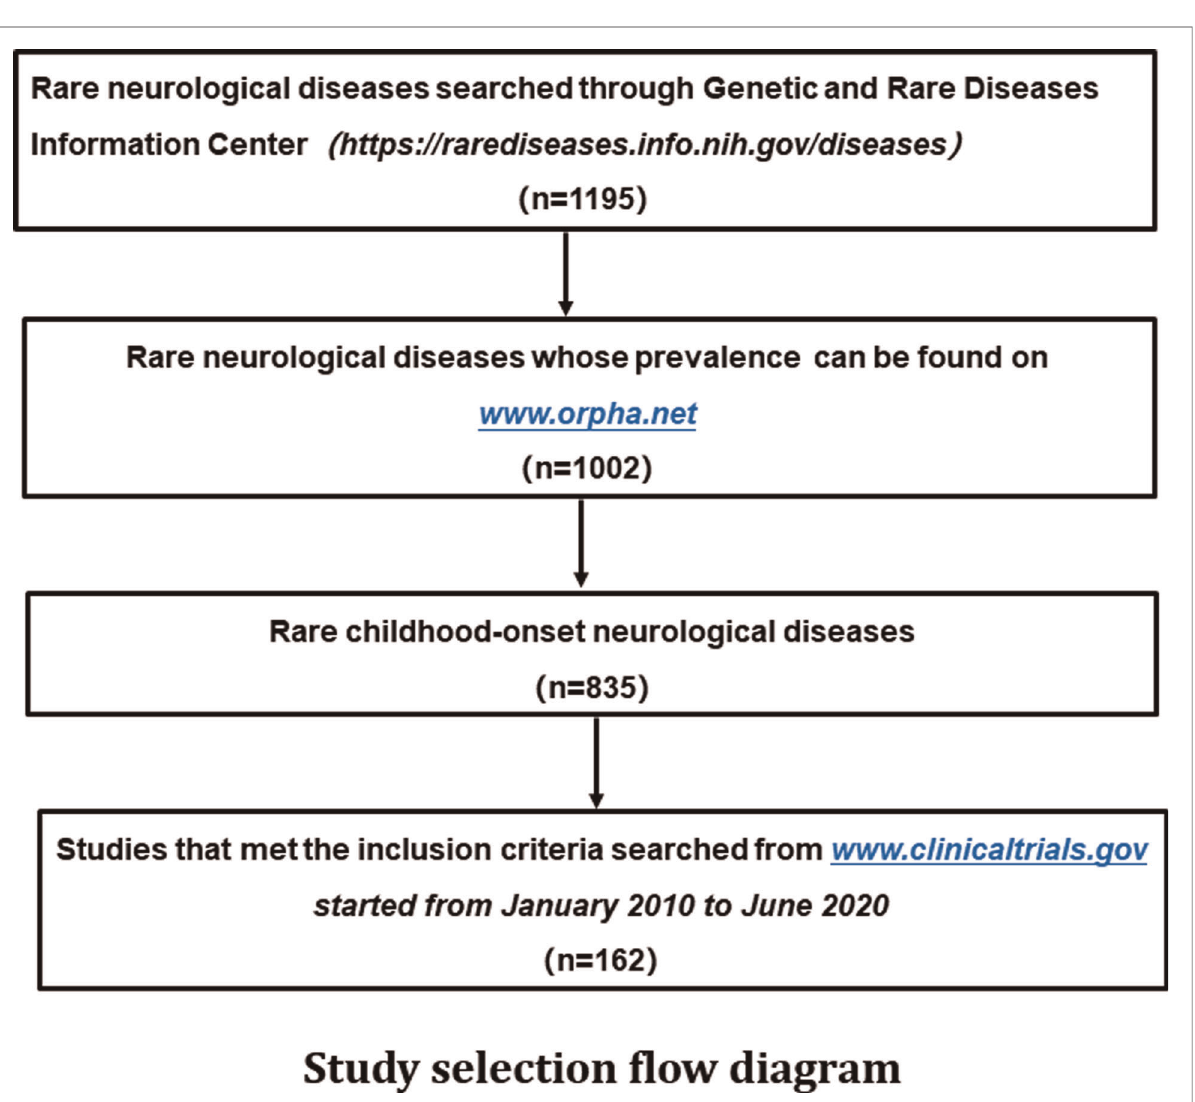
FIGURE 1 Study selection fl ow diagram A total of 1,195 rare neurological diseases were identi fi ed through the genetic and rare diseases information center (https://rarediseases.info.nih.gov/diseases), of which 1,002 diseases could be found on www.Orpha.net. A total of 835 diseases affected either children only or both children and adults. Further search in ClinicalTrials.gov found a total of 162 clinical trials on above diseases were registered from January 2010 to June